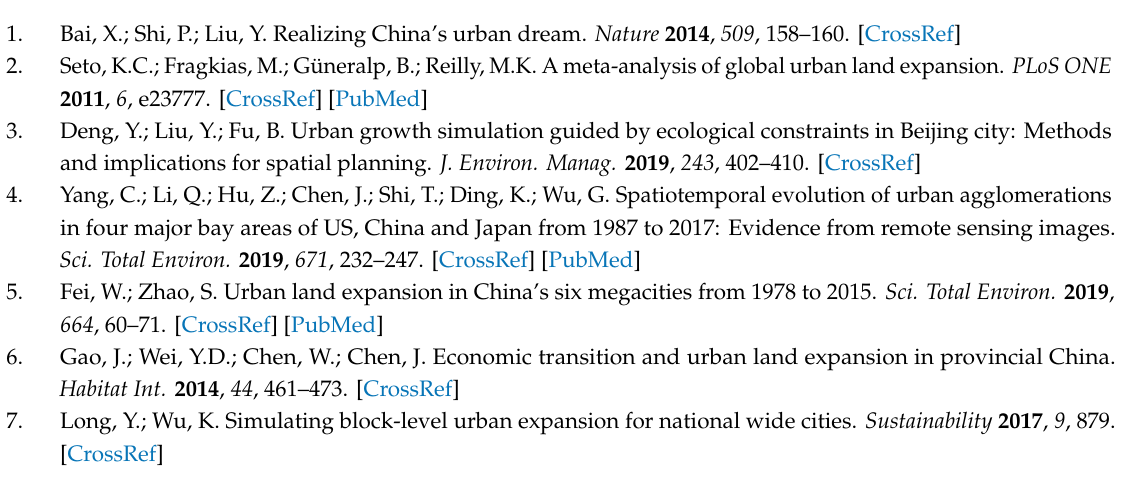
Table S1: Expanding amount of each city under di ff erent scenarios and total USE